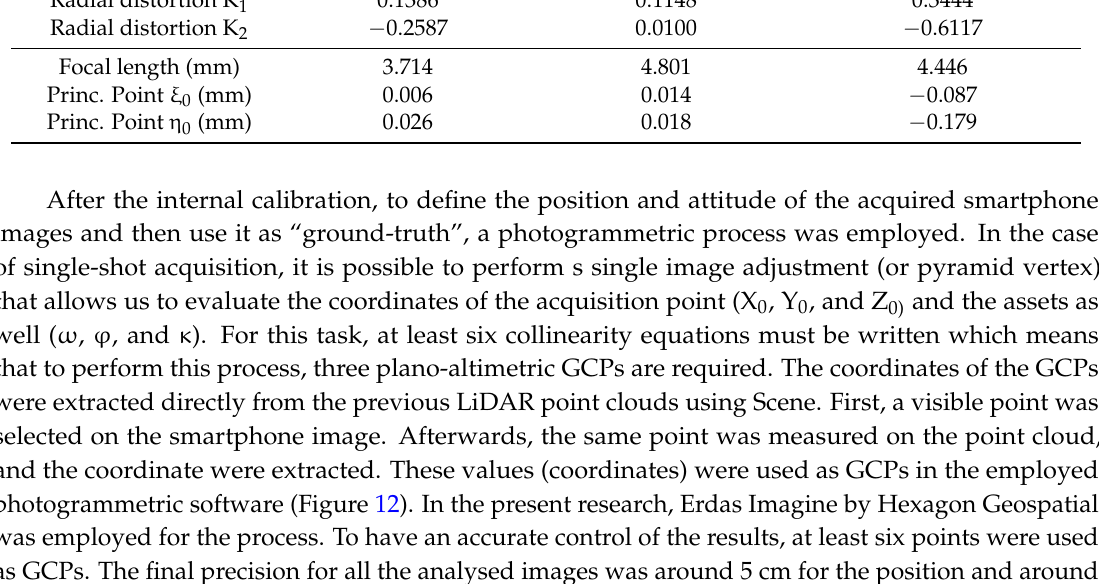
( b ) Figure 12. ( a ) GCP coordinate extraction from LiDAR data; and ( b ) GCP measurement in Erdas.